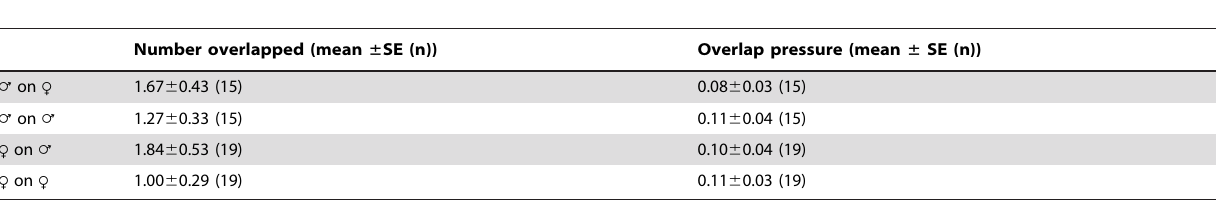
Table 3. Measures of home range overlap in P. vlangalii for adult males with at least 11 sightings (n=14) and females with at least 8 sightings